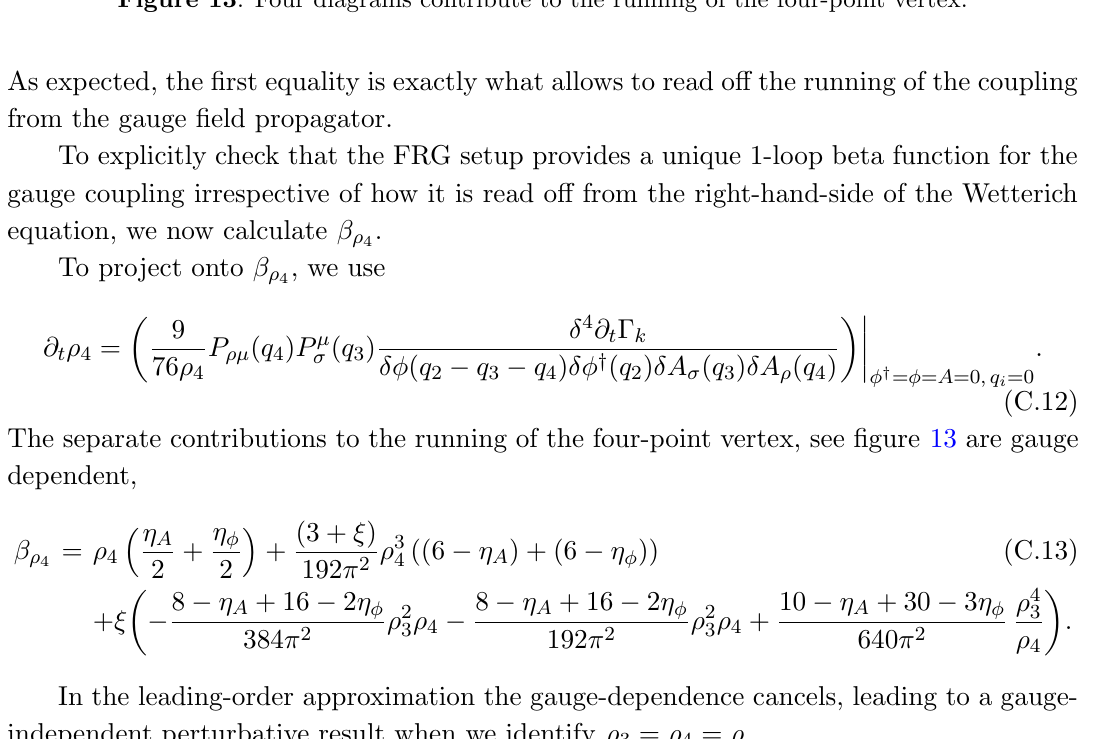
Figure 13 . Four diagrams contribute to the running of the four-point